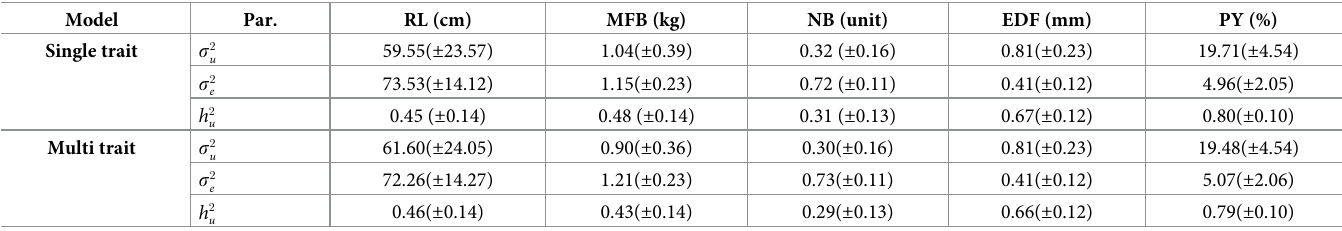
), residual variance ( s 2 ), narrow-sense heritability ( h 2 ) and their respective stan- u e u